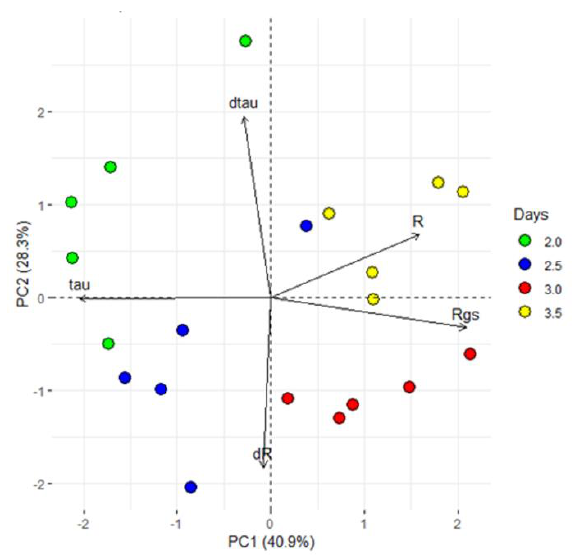
Figure 8. Principal component analysis (PCA). PCA used the processed data, which consist of the sensor response (R), the difference between minimum and maximum current gate values (∆I gs ), the sensor constants time (τ and τgs) and the first derivative as function of time of R and τ (dR and dτ) and exhibited clear separation between the groups with different periods of exposure to VPD variations (2, 2.5, 3 and 3.5 dpi). The first two components PC1 and PC2 explain the 69.2% of the variability observed.